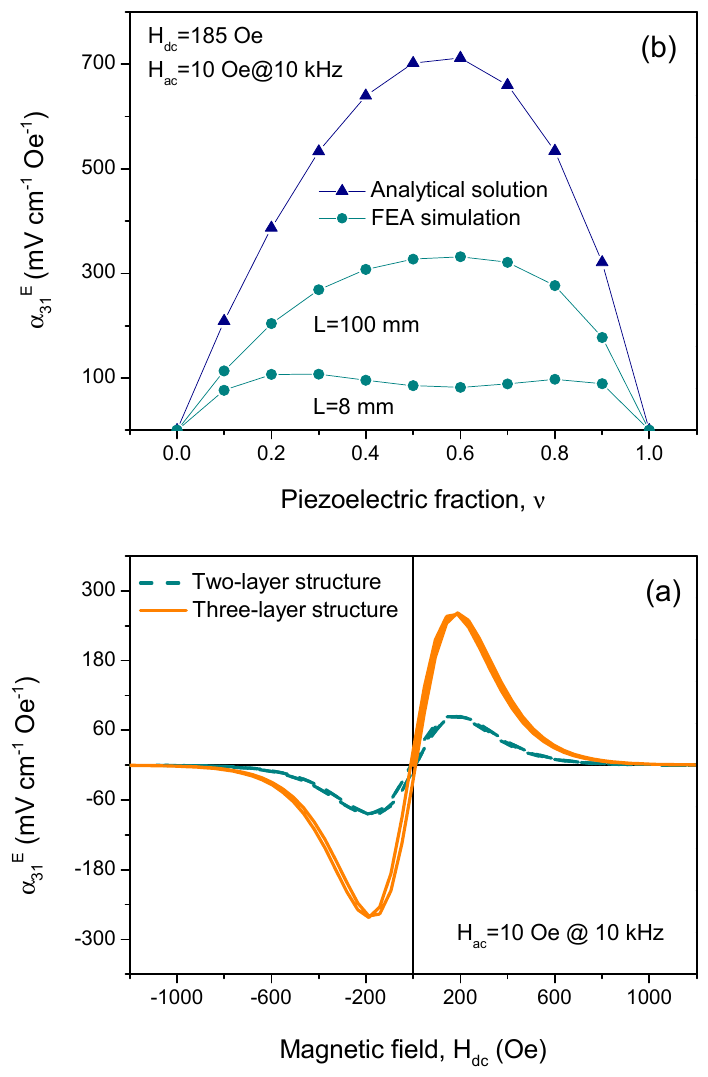
Figure 3. Comparison of ( a ) the magnetoelectric coefficient α 31 E resulting from the simulation of 8 mm long, 2 mm thick two-layer and three-layer structures with a piezoelectric fraction of 0.5; and ( b ) the piezoelectric fraction dependence of α 31 E anticipated by the analytical solution of [12] for a bilayer, and those resulting from the simulation of 1 mm/1 mm two-layer structures with 8 mm and 100 mm in-plane dimensions. Materials coefficients corresponding to processing at 1000 °C have been used.